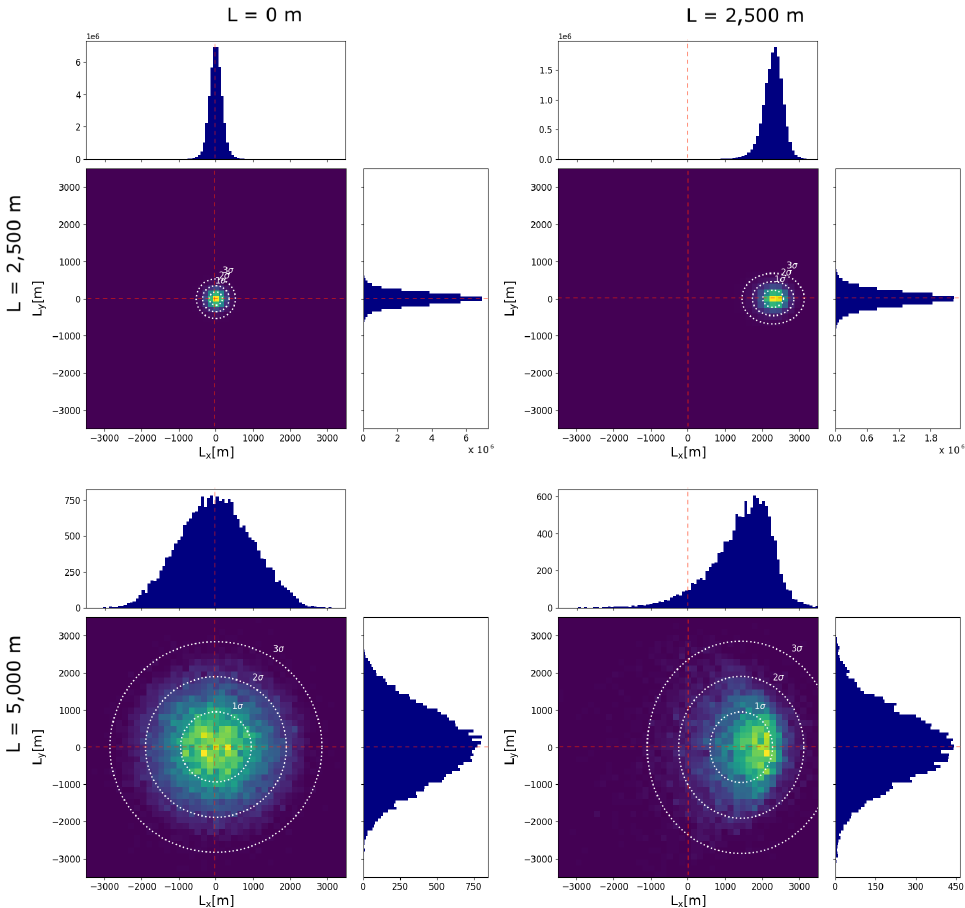
Figure 3. Spatial distribution at Mt. Cimone (2,165 m altitude) of TGF gamma-ray photons emitted at positions ( L , H ) = (0.0 km, 2.5 km), ( L , H ) = (2.5 km, 2.5 km), ( L , H ) = (0.0 km, 5.0 km), and ( L , H ) = (2.5 km, 5.0 km). Corresponding 1 σ , 2 σ , and 3 σ of the distribution are reported for each plot. The red dashed lines indicate the position of Gamma-Flash, located in ( L , H ) = (0.0 km, 0.0 km). It is interesting to notice that, given the large emission angles, the peak of the survived flux always lays below the source position ( L , H ) , rather than at the target point placed in ( L , H ) = (0.0 km, 0.0 km).